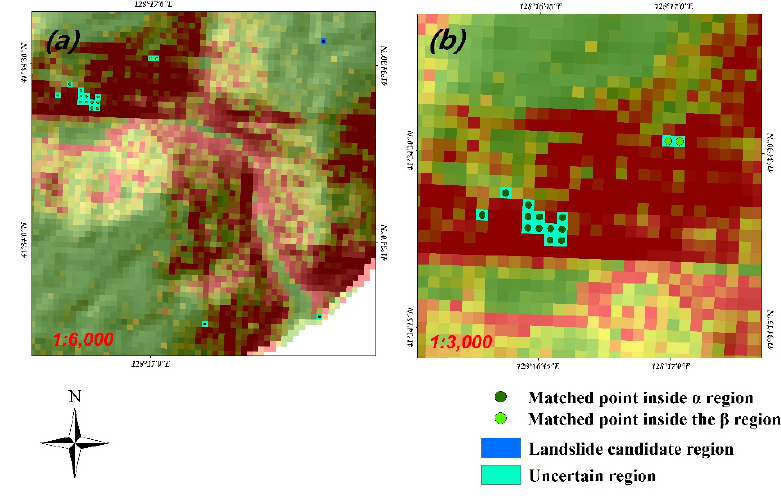
Figure 17. ( a ) Different color point. ( b ) Final results.